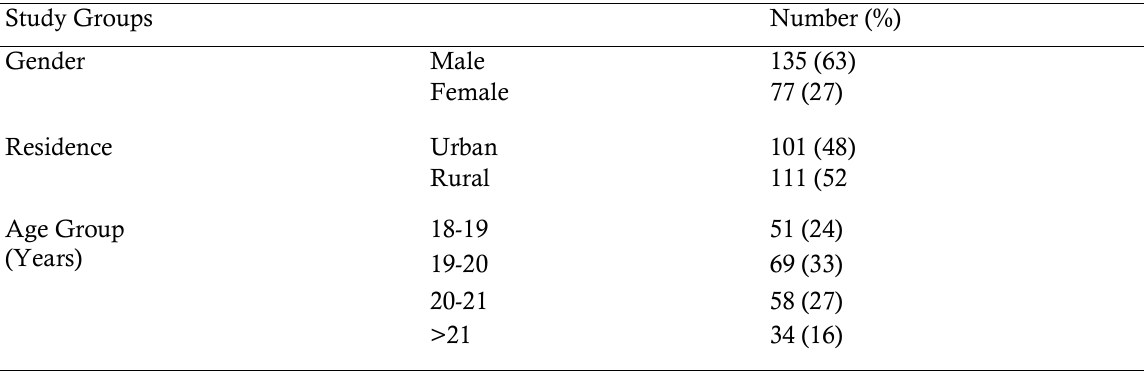
Table 1 <Demographic Profile of Medical Students (number of students=